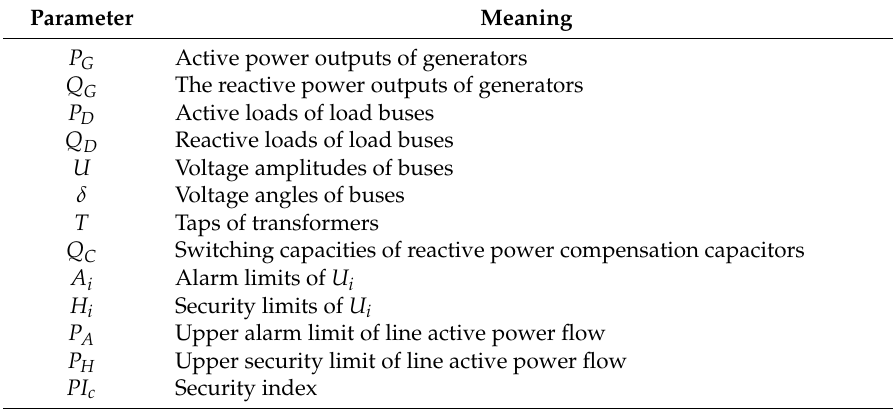
Table 2. The main parameters in Section 4.